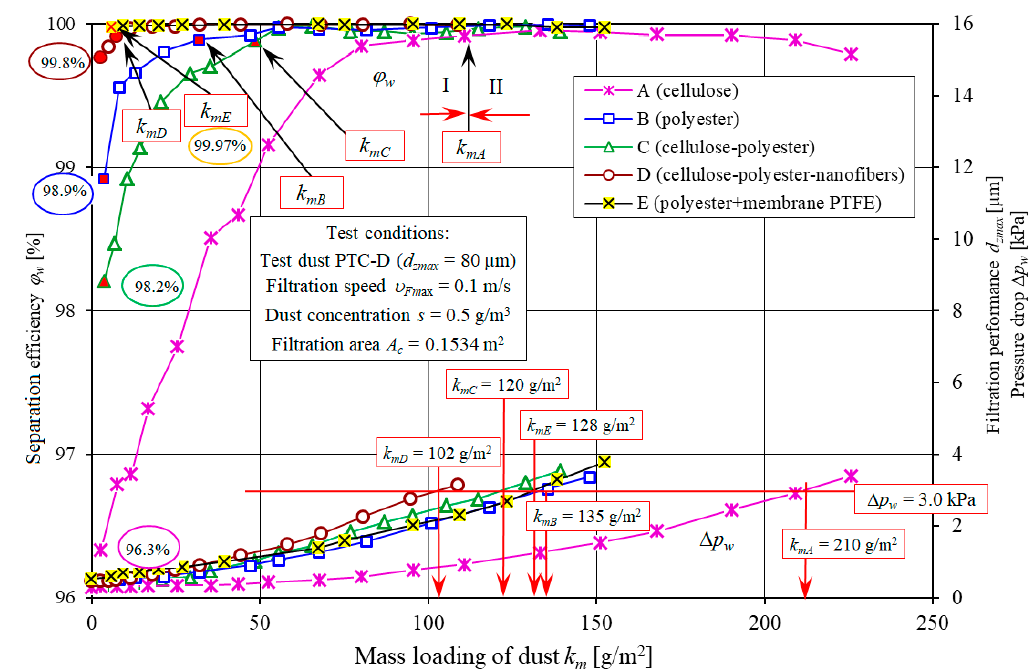
Figure 14. Separation efficiency φ w and pressure drop ∆ p w as a function of the mass loading of dust k m of the tested filter elements A, B, C, D and E.